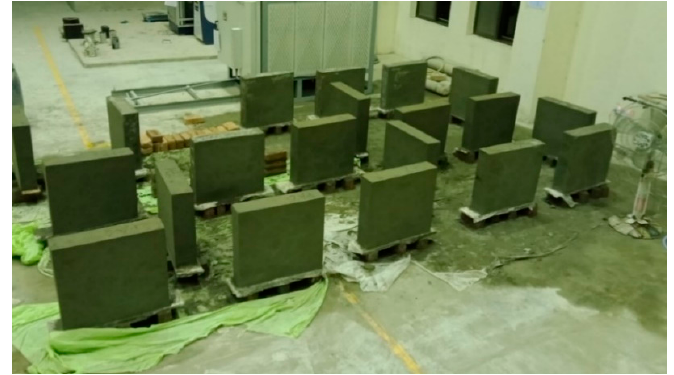
Figure 4. Masonry wallets after plastering.